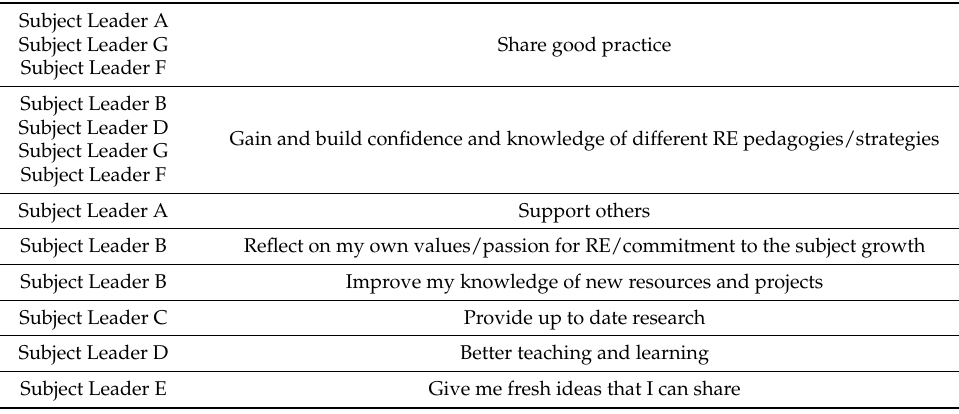
Table 4. Openness to learn about pedagogies and leadership: aligned with curiosity and